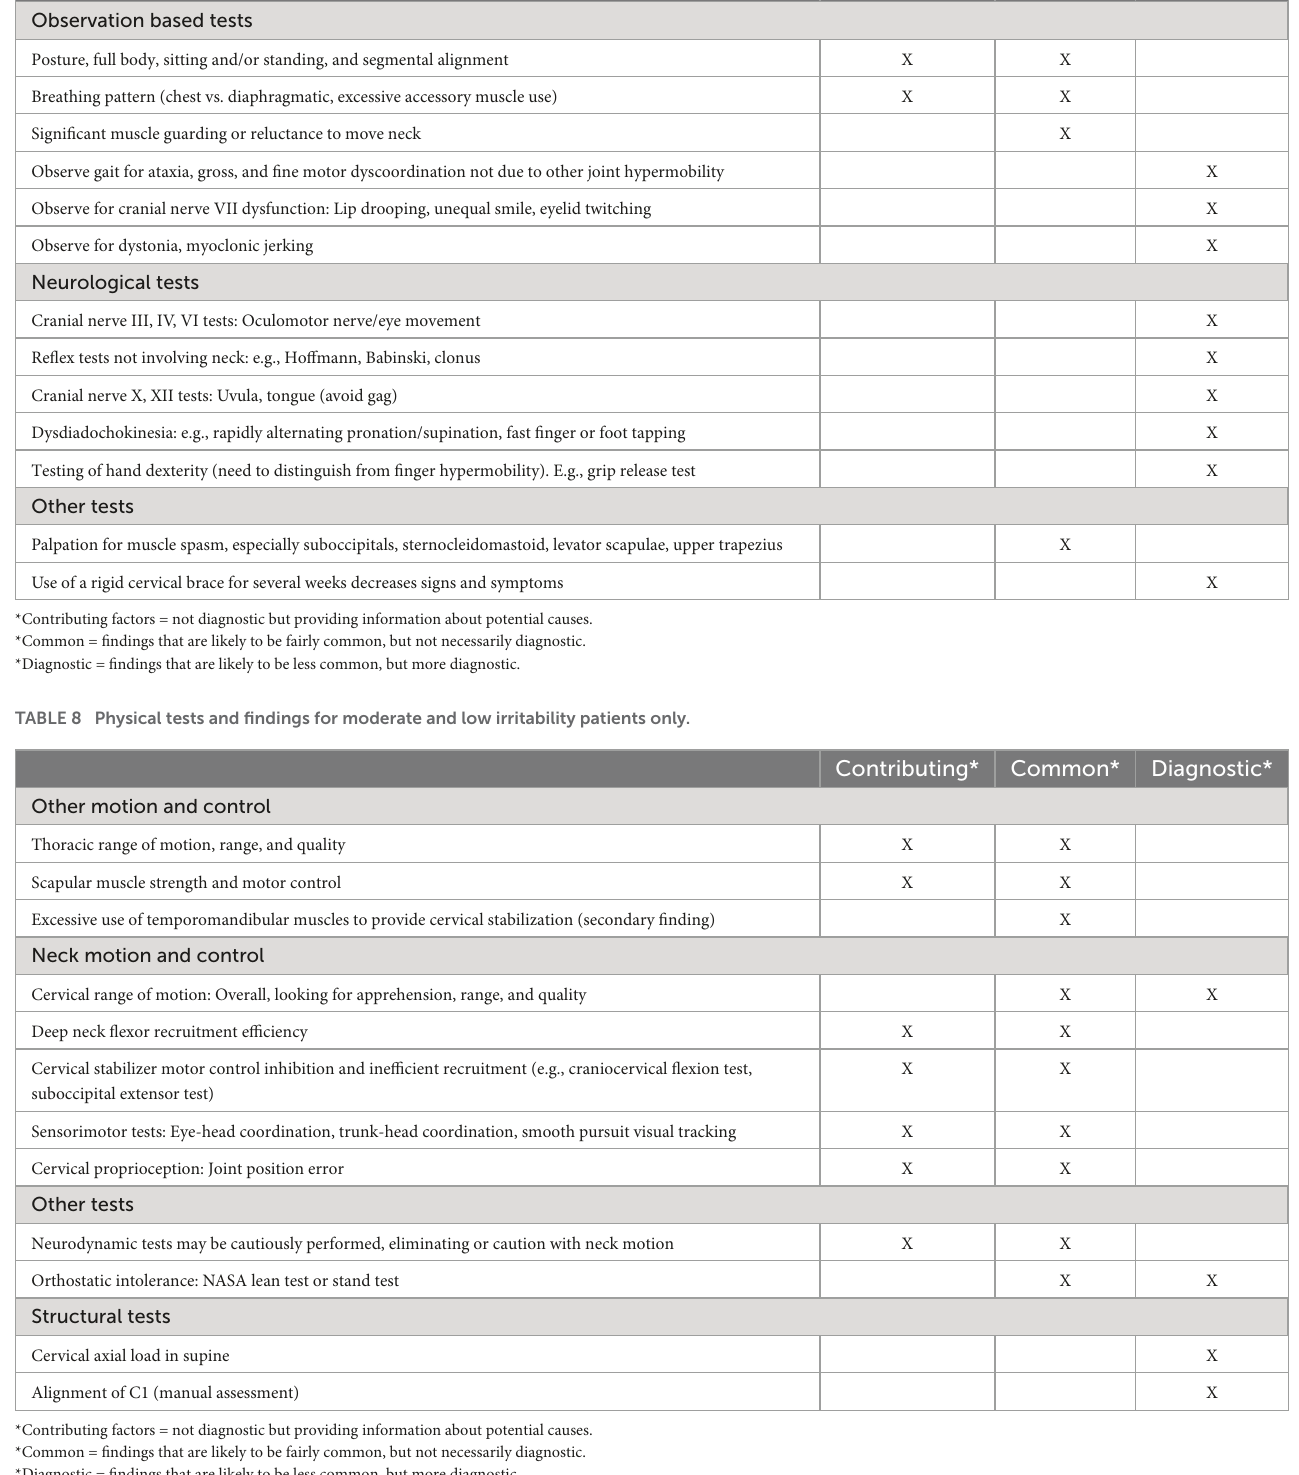
TABLE 7 Physical test and findings, safe for all patients. Observation based tests